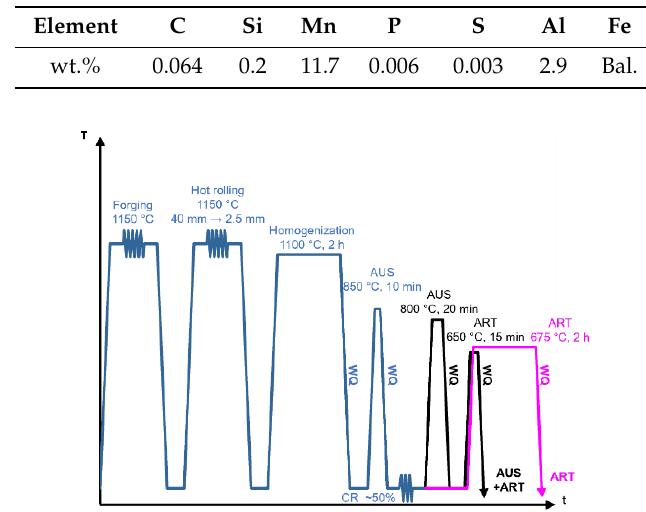
Figure 1. Schematic illustration of thermal cycles on cold-rolled Fe-12Mn-3Al-0.05C steel after cold rolling (WQ denotes water cooling; CR denotes cold rolling).